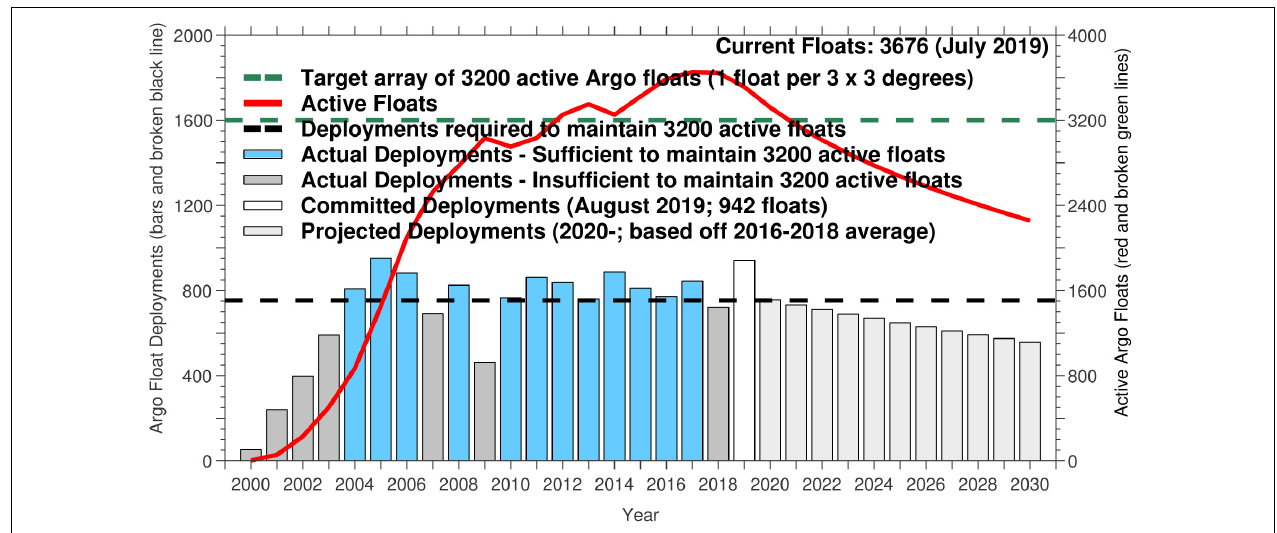
FIGURE 10 | The time history of Argo Programme deployments since 2000, and float coverage projections into the future assuming a business as usual funding scenario across the 30 partner countries. The broken green line shows the target 3200 active Argo float (right y -axis), since 2010 this target was met, but deployments dropped below this value in 2018. The broken black lines show the ∼ 800 float annual deployments required (left y -axis) to maintain the 3200-strong array. If additional deployments are not prioritized, the array will start falling beneath the deployments required to maintain the 3200-strong global target array in ∼ 2021, with a continuing degradation of the array from 2022 onward (based off the average deployments from the last 3 years 2016–2018; updated from Durack et al., 2016). The expansion of the program to include BioArgo and Deep Argo needs to be prioritized in a way that preserves the physical observing capability of the core